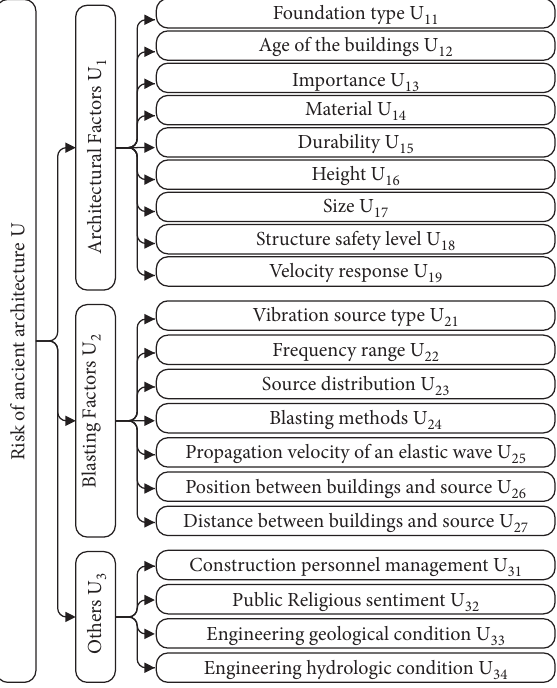
Figure 5: The risk assessment